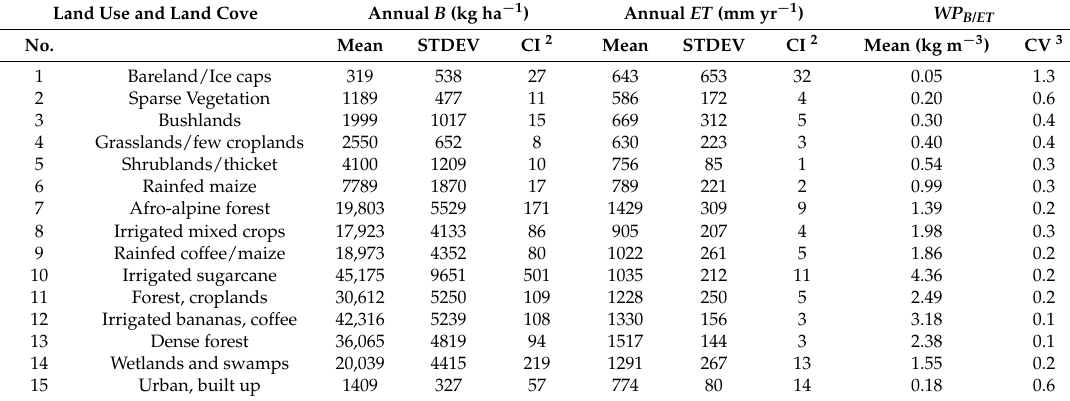
Table 6. Average above-ground biomass ( B ), actual evapotranspiration (ET), and water productivity ( WP B/ET ) in the Upper Pangani River Basin, for the period of